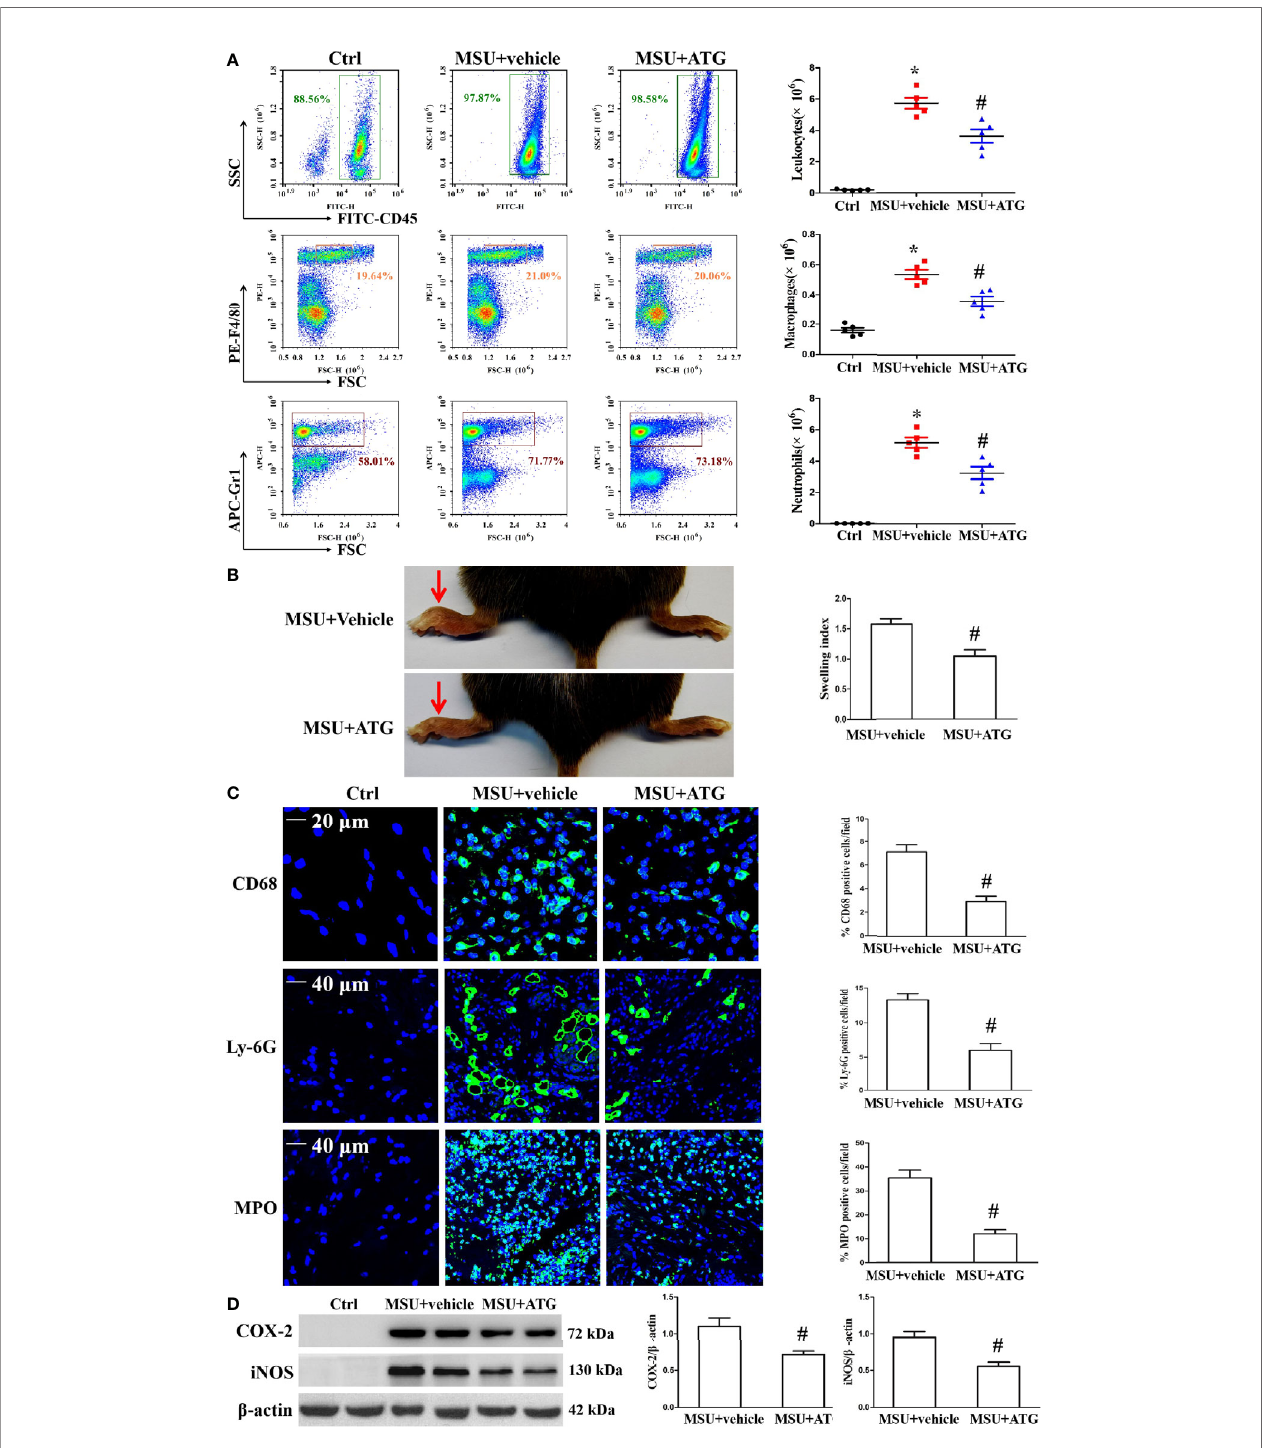
FIGURE 8 | Effects of ATG on MSU crystal-induced in fl ammatory cell in fi ltration and cytokine release in a mouse model of peritonitis and arthritis. (A) After the cells precipitated from the peritoneal fl uid and were respectively stained with FITC-CD45 Ab, PE-F4/80 Ab, and APC-(Ly-6G and Ly-6C) Ab. The percentage and cell numbers of migrated leukocytes, macrophages, and neutrophils were analyzed using FACS. (B) Paw swelling index. (C) An immuno fl uorescence assay was used to detect macrophage, neutrophil and MPO positive cells distribution in mouse foot pad tissue sections. Blue shows nuclei stained with Hoechst 33342. (D) Western blot assays were used to measure the protein levels of COX-2 and iNOS in foot pad tissue. n=5 for each group, *P < 0.05 vs. Ctrl; # P < 0.05 vs. MSU crystals + vehicle. All the data are expressed as the means ± SEM from n=3 independent